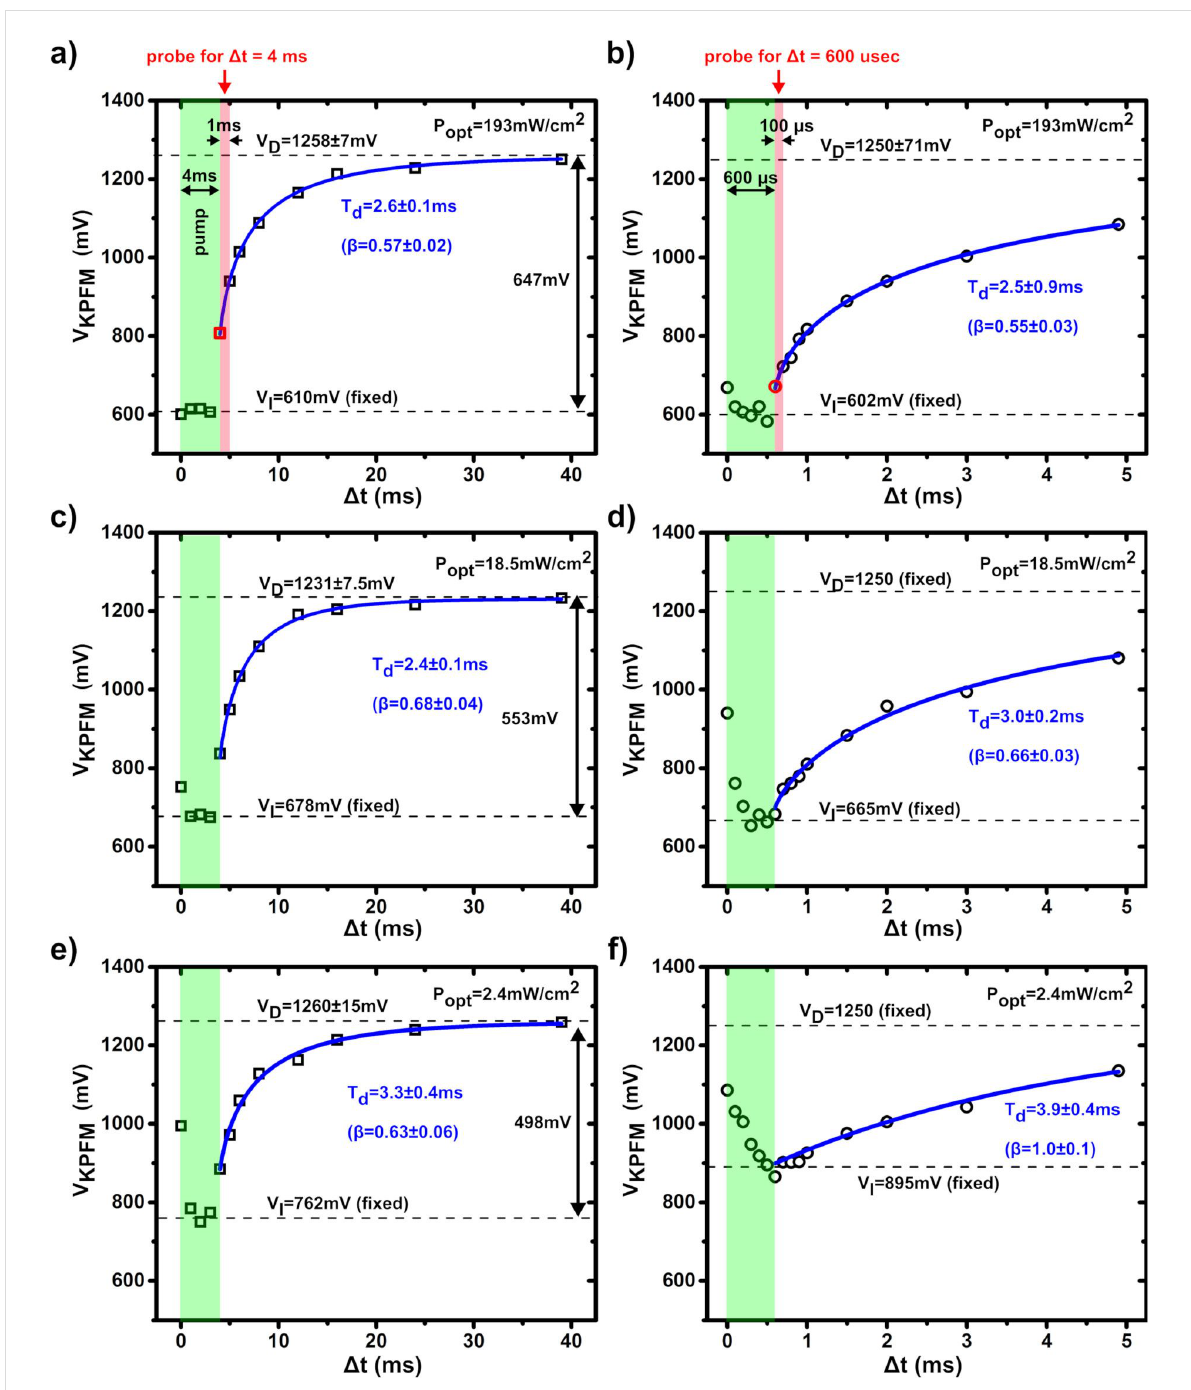
Figure 6: (a–f) Spectroscopic curves (average of 5 acquisitions) of the pp-KPFM compensation potential as a function of Δ t measured at the solar cell cathode. The data were acquired using three different illumination intensities (peak power of the pump pulses): (a, b)193 , (c, d) 18.5 and (e, f) 2.4 mW ∙ cm − 2 . Two different pump–probe delay sequences were used. Open squares and open circles represent data of the first and second se- quence, respectively. (a, c, e) First sequence: 4 ms pump pulses repeated at 25 Hz, 1 ms probe-time window, post-data acquisition delay of 2 s, inte- gration time 1 s. (b, d, f) Second sequence: 600 µs pump pulses repeated at 200 Hz, 100 µs probe-time window, post-data acquisition delay of 2 s, in- tegration time 1 s. The time intervals corresponding to the pump (a–f) and the probe (a, b) signals (shown only for one given delay) are highlighted by half-transparent green and red rectangles, respectively. Note that the time ( t ) and delay ( Δ t ) scales coincide since the delays are defined with respect to the time origin t = 0 s. However, each data point represents a measurement of the SP integrated during the pump–time window. The solid blue lines represent the results of the numerical curve fits performed to extract the SPV decay-time constants ( τ d ). For the fit, the V I values were fixed at the value reached upon illumination. V D , τ d , β were free variables, with the exception of the data in (d) and (f), that were adjusted with fixed V D